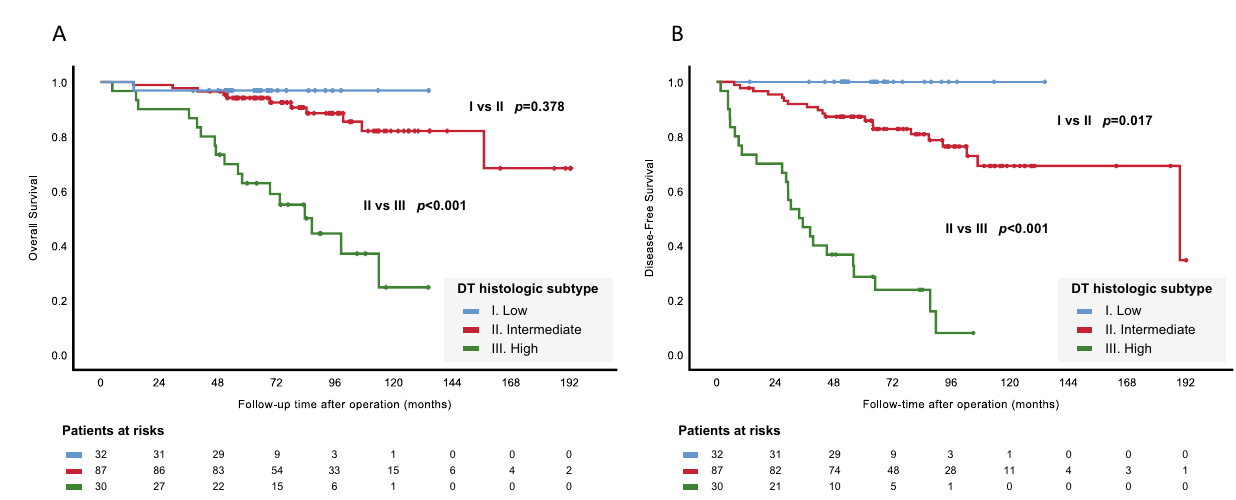
Figure 2. Overall and disease-free survival between different histologic subtypes ( A , B ) of the dominate tumor.